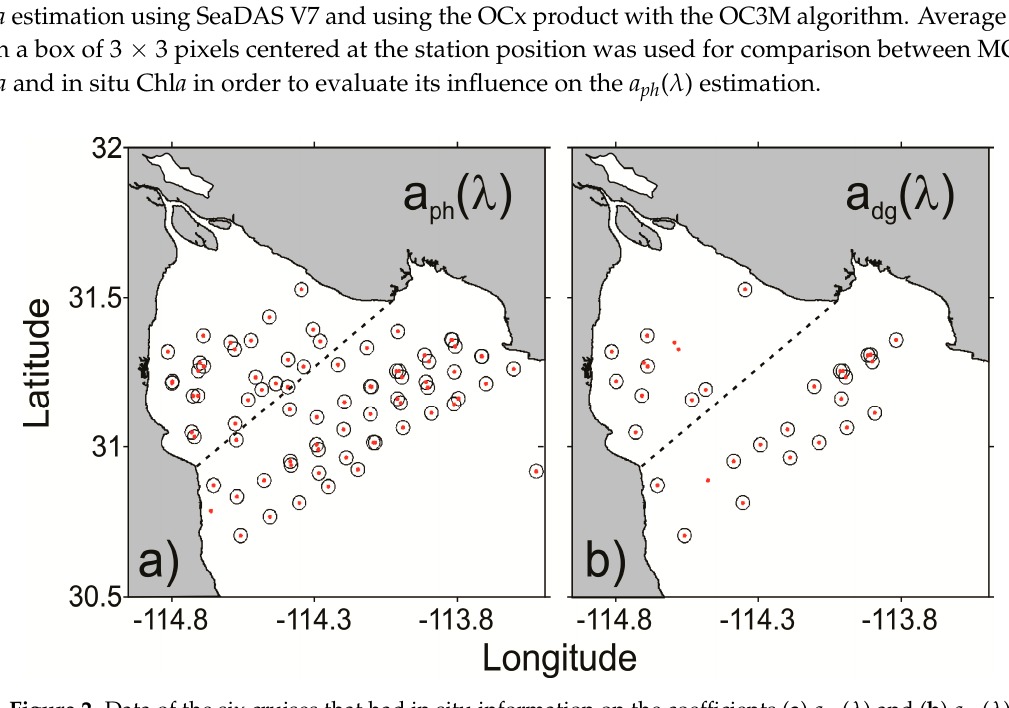
Figure 2. Data of the six cruises that had in situ information on the coefficients ( a ) a ph ( λ ) and ( b ) a dg ( λ ) in the study zone. Black circles represent stations paired with the Generalized Inherent Optical Property (GIOP) algorithm, and red points represent stations paired with the Garver-Siegel-Maritorena (GSM) algorithm. The dotted black line represents the intermediate position of the transitional zone that separates the bio-optical regions UGC and NGC [29].